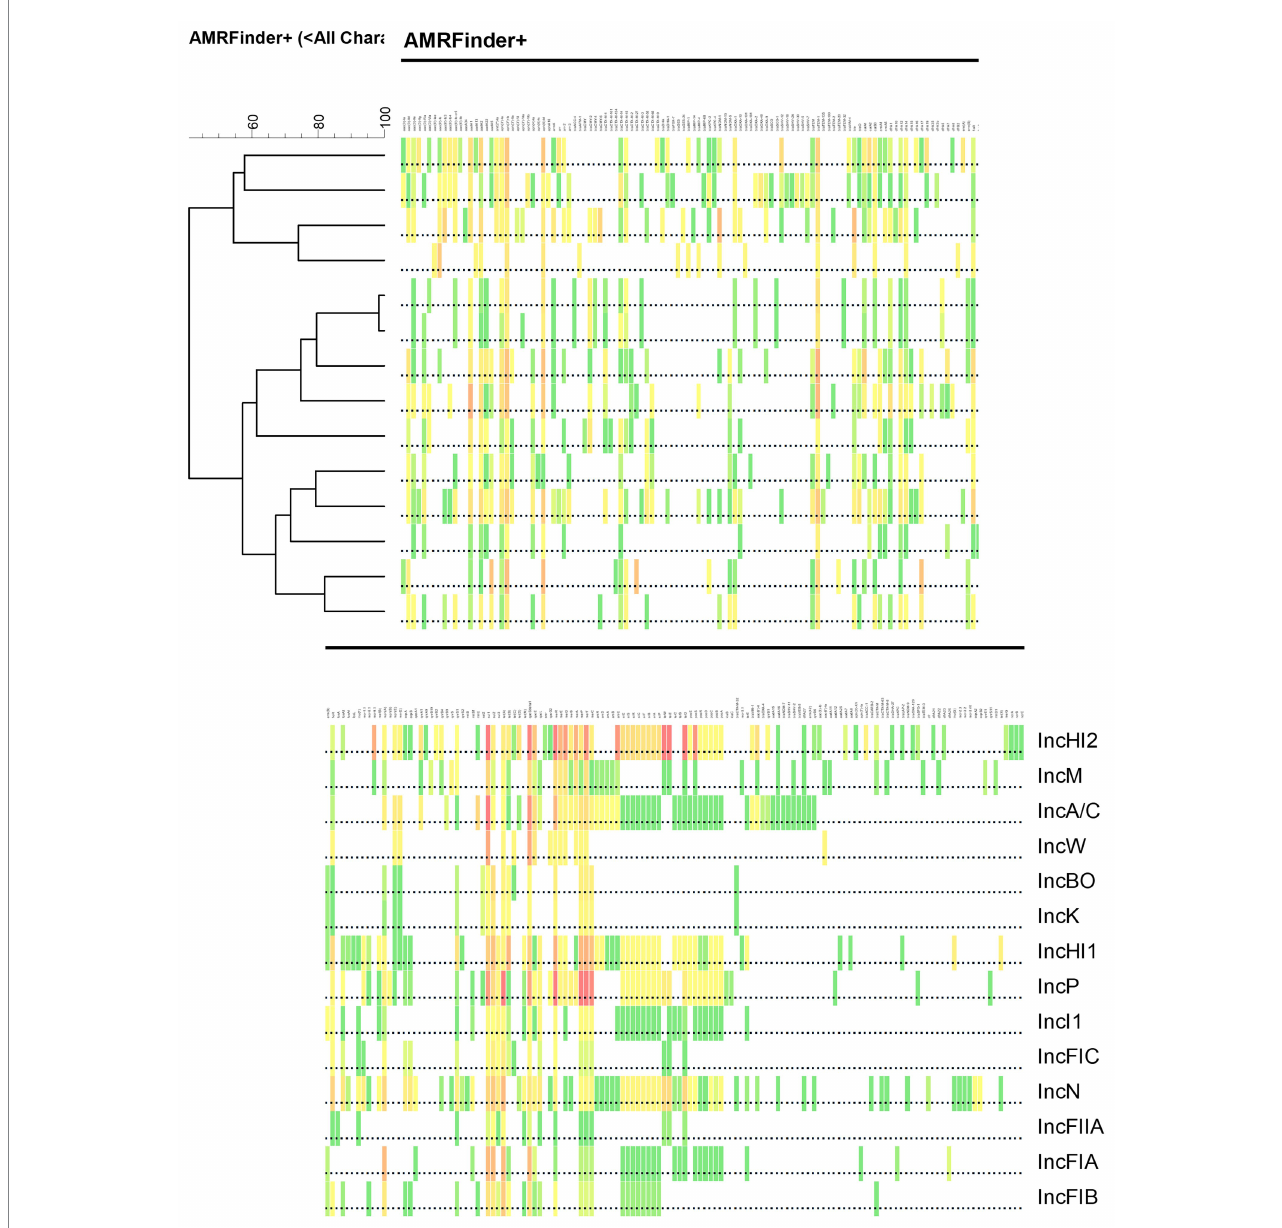
FIGURE 3 Illustration of clustering heat map association between different replicon type based on a combination of antimicrobial resistance (AMR), disinfectant and biocide resistance (DBR) and heavy metal resistance (HMR) data from Tables 1–3, respectively. Clustering analysis was performed using Pearson correlation of numerical values using BioNumerics software to generate the dendrogram using the unweighted pair group means with averages (UPGMA) algorithm. The colors of the boxes correspond to those in the